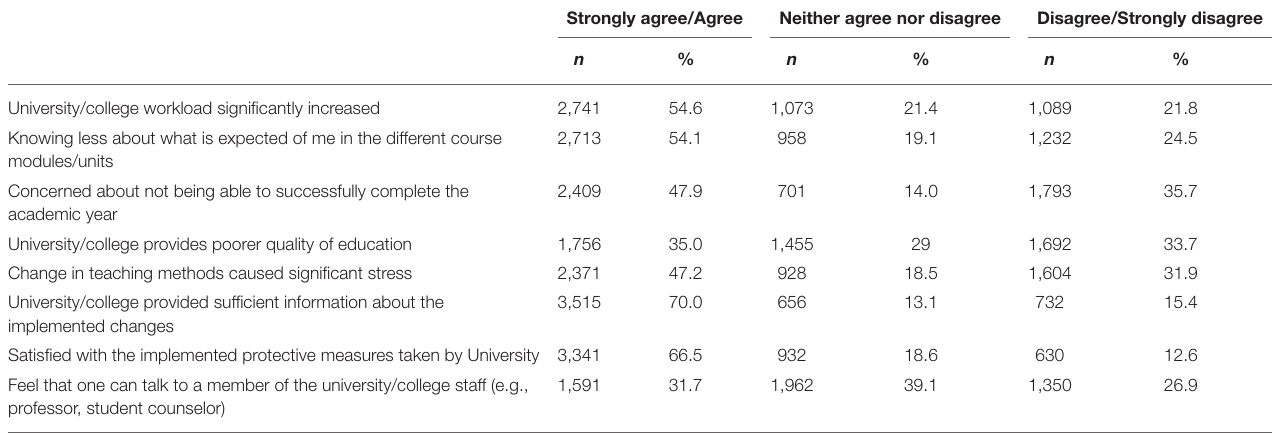
TABLE 3 | Perceived study conditions among University students ( n = 4,903).